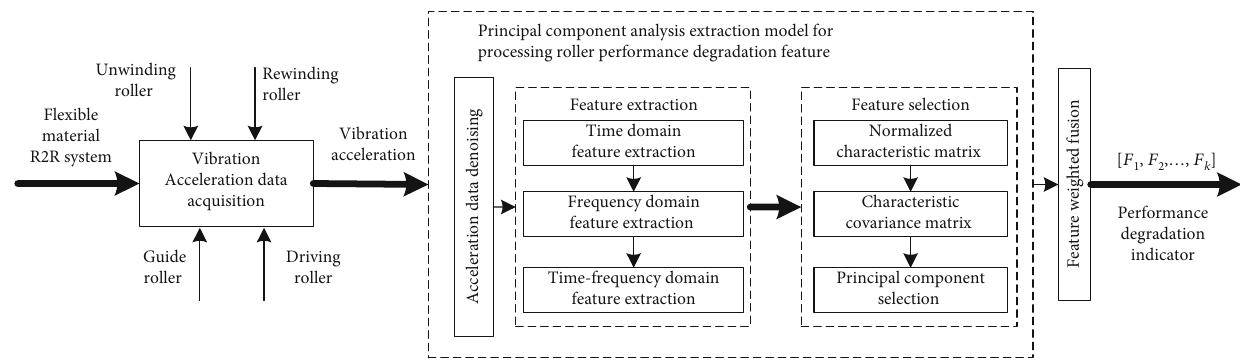
Figure 1: R2R processing roller shaft performance degradation feature extraction model